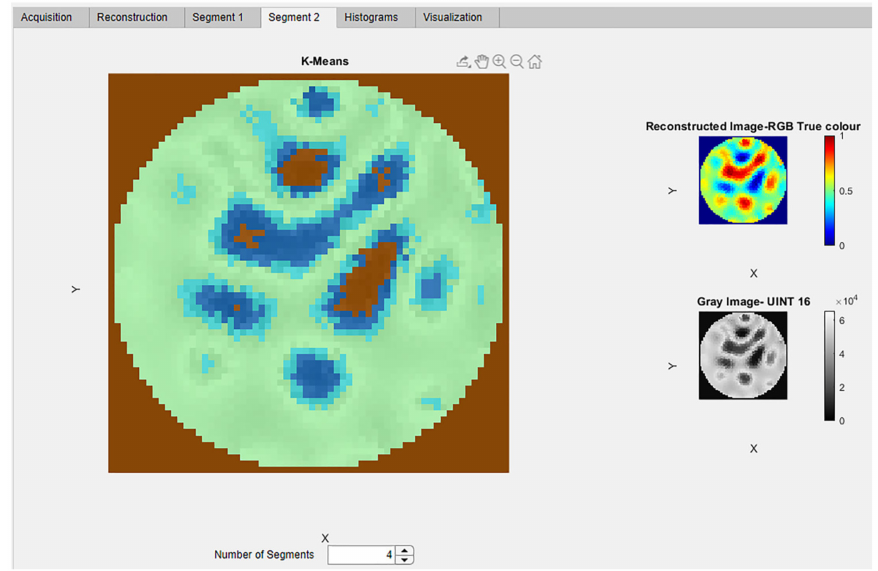
Figure 10. Segmentation module: Advanced segmentation tabs for observing the K-means clusters for the crystal regions. The reconstructed RGB image and gray image is also displayed in panel.